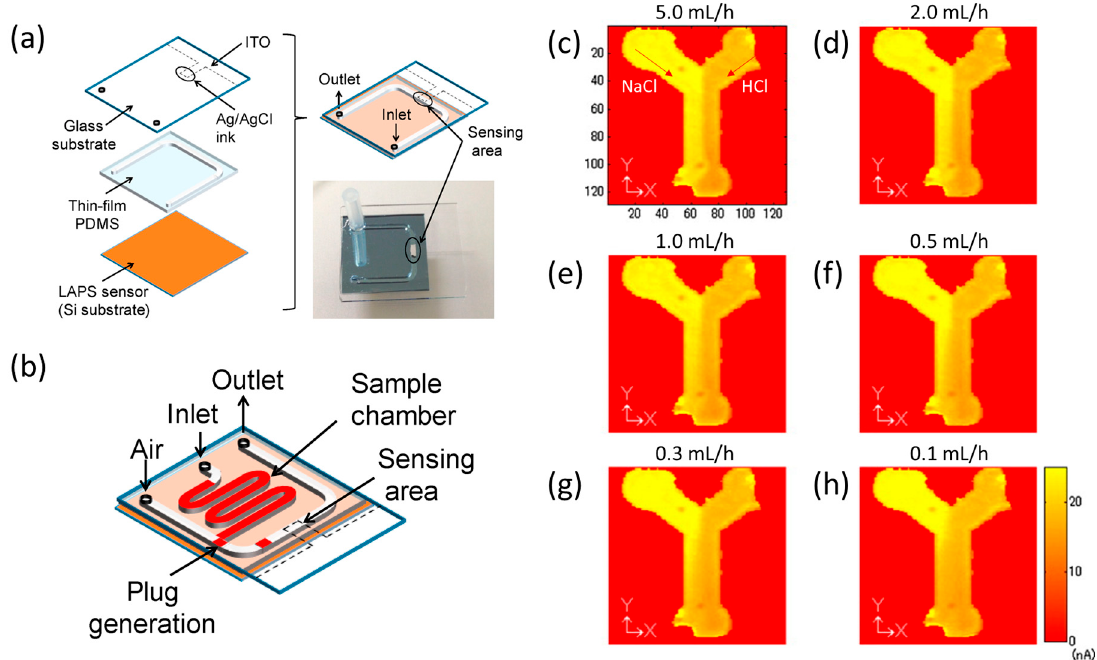
Figure 8. ( a ) Schematic of the microfluidic devices combined with LAPS; ( b ) Microfluidic channel design for plugs generation on LAPS chip. Reprinted from; Chemical images of the laminar flows in the Y-shaped channel under the injection rates from ( c ) 5.0 mL/h to (h) 0.1 mL/h. Reprinted